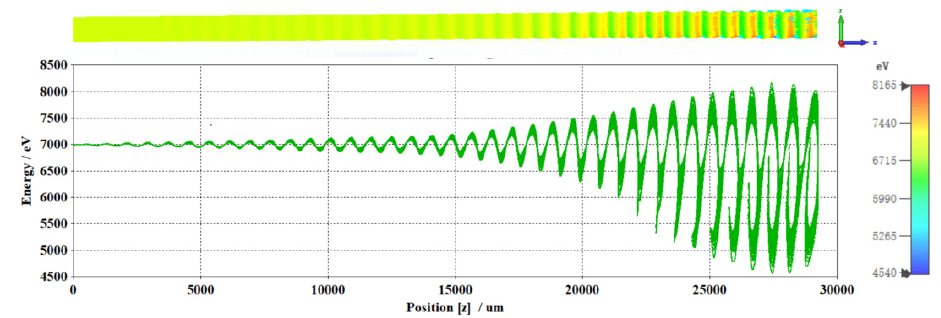
Figure 10. Phase space diagram.